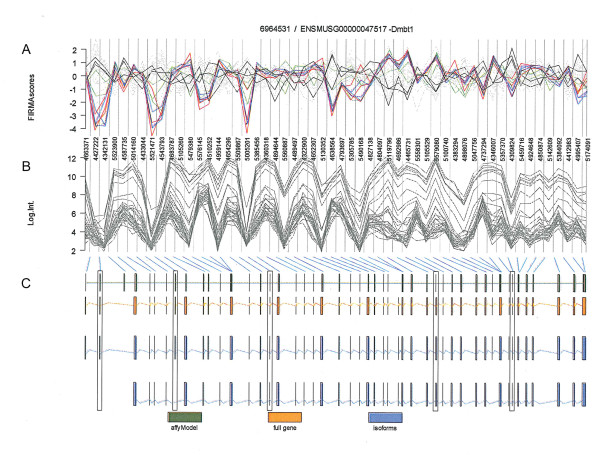
Exon array analyses of alternative splicing of Dmbt1 gene with FIRMA. A, FIRMA scores calculated from array data for all the mice are plotted in the top graphic. Each line represents values from a single mouse. Highlighted in colour are 8-week old mice [black, WT on control diet; green, PTEN null on control diet; blue, PTEN null on LSF diet; red, PTEN null on HSF diet]. B, The normalised logged intensities of each probeset are plotted (note that certain exons are represented by more than one probeset). The blue connecting lines map these probesets to (C) gene models as defined by Affymetrix (green) and Ensembl (orange). Transcript isoforms known for this gene are plotted in dark blue. The longer isoform is designated in Ensembl as Dmbt1-202 and the shorter as Dmbt1-201 (see Figure 13). The five regions highlighted in the plot show exons with statistically significant difference in FIRMA scores between 8-week PTEN null mice on HSF diet and WT mice on control diet.